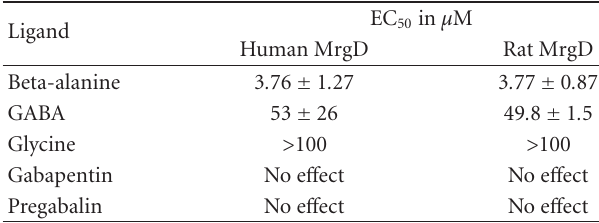
Table 1: EC 50 values obtained for MrgD agonists. Data represents mean ± standard deviation from 2–6 independent